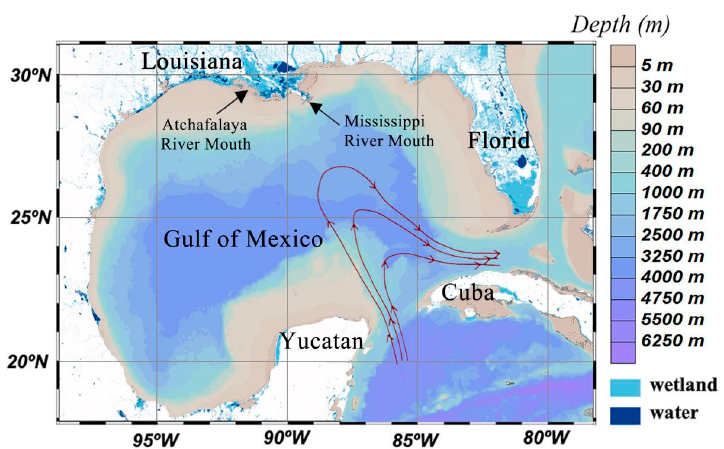
Figure 1. Geographical location of the Gulf of Mexico (GOM); distribution of its river and wetlands; water depth and typical Loop Current path in the GOM.